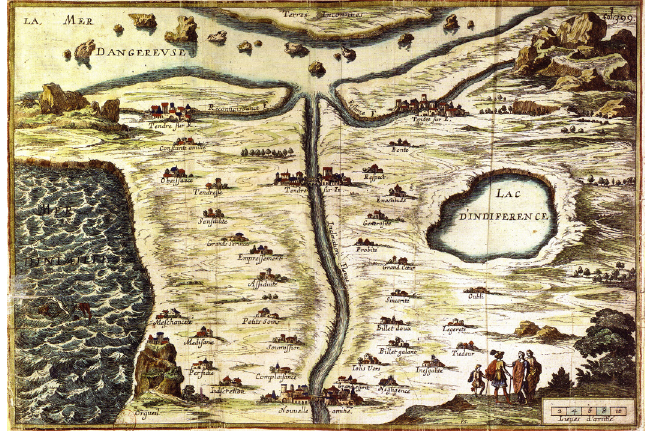
Fig. 16 Madeleine de Scudéry and François Chauveau, Carte du Pays de Tendre , 1654. The Map appeared in the first volume of the novel Clélie